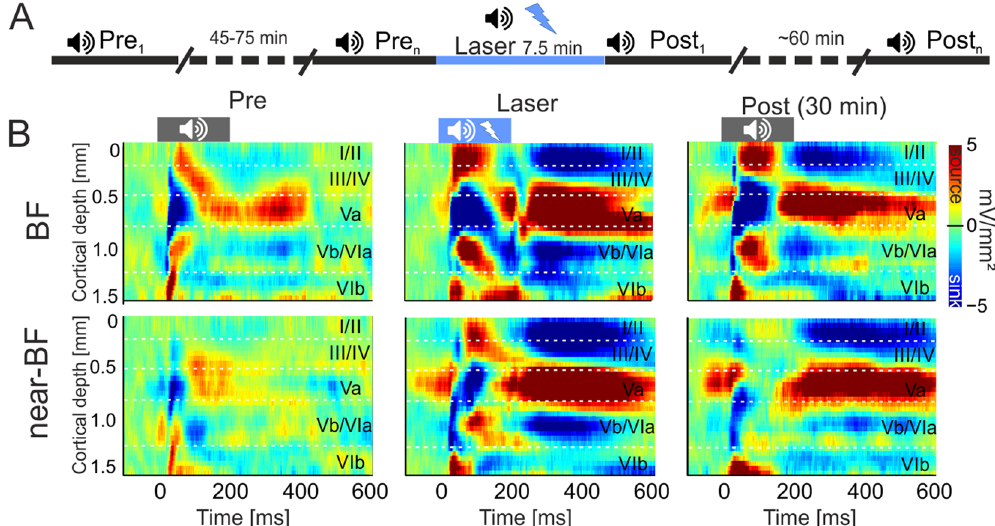
Figure 2. Electrophysiological measurements and effects of VTA stimulation on tone-evoked CSD profiles in AI ( A ) Schematic representation of the timeline of measurements. Pre baseline measurements (Tone stimulation: 0.125–32 kHz, tone duration: 200 ms, ISI: 0.6–0.8, 50 pseudorandomized repetitions, 65 dB SPL, 7.5 min) were performed until CSD patterns had stabilized (45–75 min). A single measurement of combined tone and laser stimulation (25 Hz, 473 nm, 10 mW) was carried out and followed by a series of post-measurements (up to 60 min). ( B ) Representative example of a CSD profile after BF- (top) and near-BF (bottom) stimulation before, during and 30 minutes after the combined tone/VTA-laser measurement from an animal of the C1V1 group. Before VTA stimulation, BF-evoked CSD profiles revealed a canonical feedforward pattern of stimulus-evoked current flow starting with initial sink components in cortical layers III/IV and Vb/ VIa. Subsequent sink activity was found in layers Va, I/II and VIb. Activity after near-BF stimulation showed a less pronounced columnar activation in the pre-condition. During paired tone and VTA stimulation, both stimulation frequencies evoked stronger and prolonged translaminar current flow, which was still enhanced 30 minutes later. Cortical layers are indicated. Dashed vertical lines indicate tone onset and